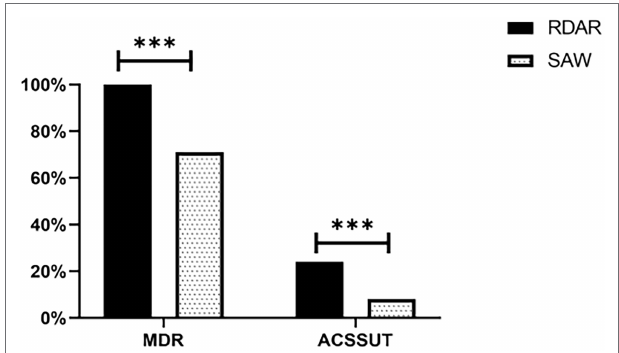
FIGURE 5 | Distribution of multi-drug resistance (MDR) in isolates and their ACSSuT profiles. MDR, Multiple antibiotic resistance; ACSSuT, resistance to Ampicillin, Chloramphenicol, Streptomycin, Sulfamethoxazole, and Tetracycline ( *** p < 0.001).